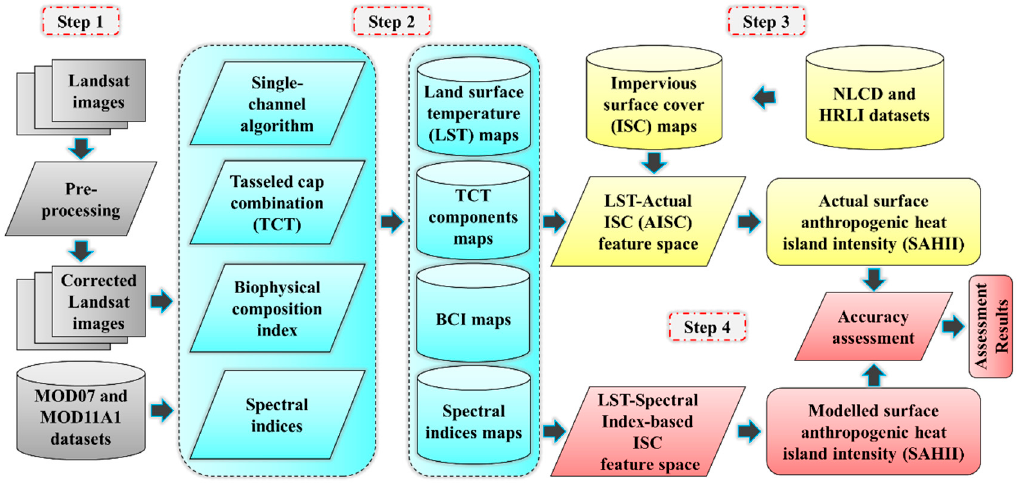
Figure 2. Flowchart of the study.